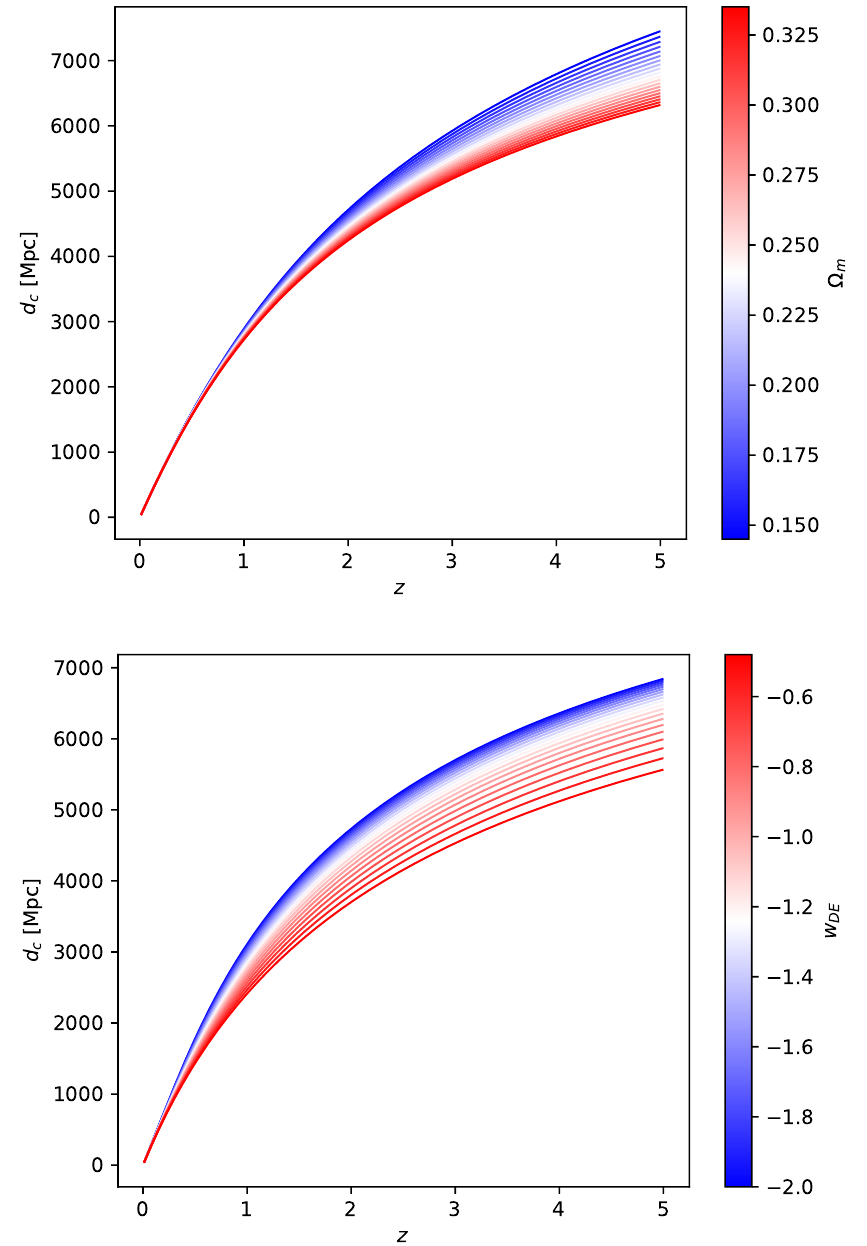
Figure 1. Comoving distance for different values of the Hubble constant H 0 ( upper panel), matter density parameter Ω m ( medium ) and the DE equation of state w DE ( lower